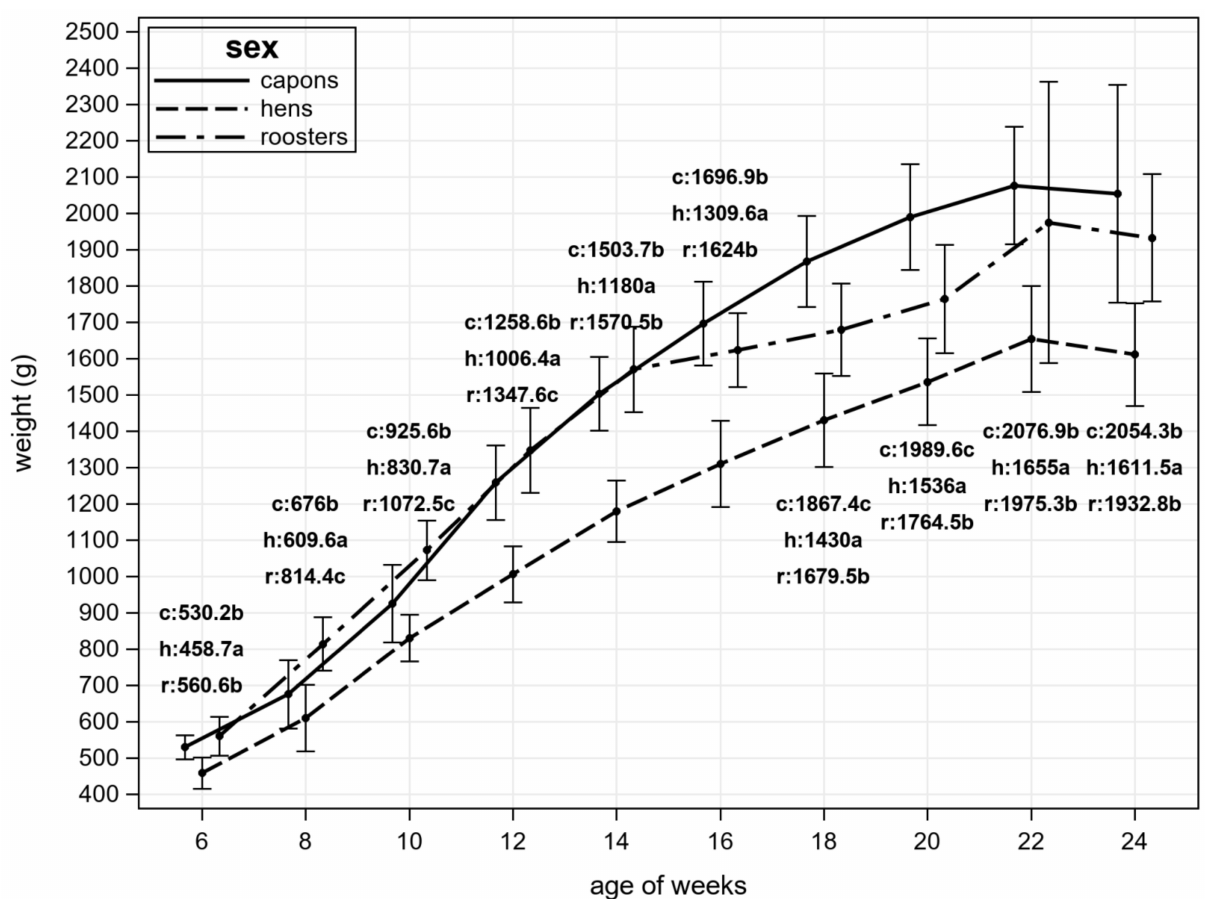
Figure 1. The body weight of roosters (r), hens (h), and capons (c) depending on their age; a,b,c means differ significantly at p ≤ 0.05 (Tukey test). Table 2. The slaughter body weight and giblets proportions of birds depending on their sex.